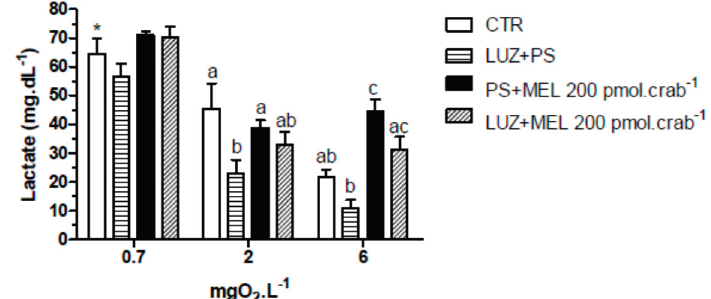
Figure 9. Circulating lactate concentration in intact Neohelice granulata exposed for 45 min to three different dissolved-oxygen concentrations (0.7, 2 or 6 mgO 2 ·L − 1 ) and injected with physiological saline only (CTR), luzindole (200 nmol·crab − 1 ) plus physiological saline, physiological saline plus melatonin (200 pmol·crab − 1 ), or luzindole (200 nmol·crab − 1 ) plus melatonin (200 pmol·crab − 1 ). Each point represents the mean ± SE ( n = 4–6). Different letters represent significant differences ( p < 0.05) between the groups with the same dissolved oxygen concentration. * represents a significant difference ( p < 0.05) from the CTR group at 6 mgO 2 ·L − 1 .